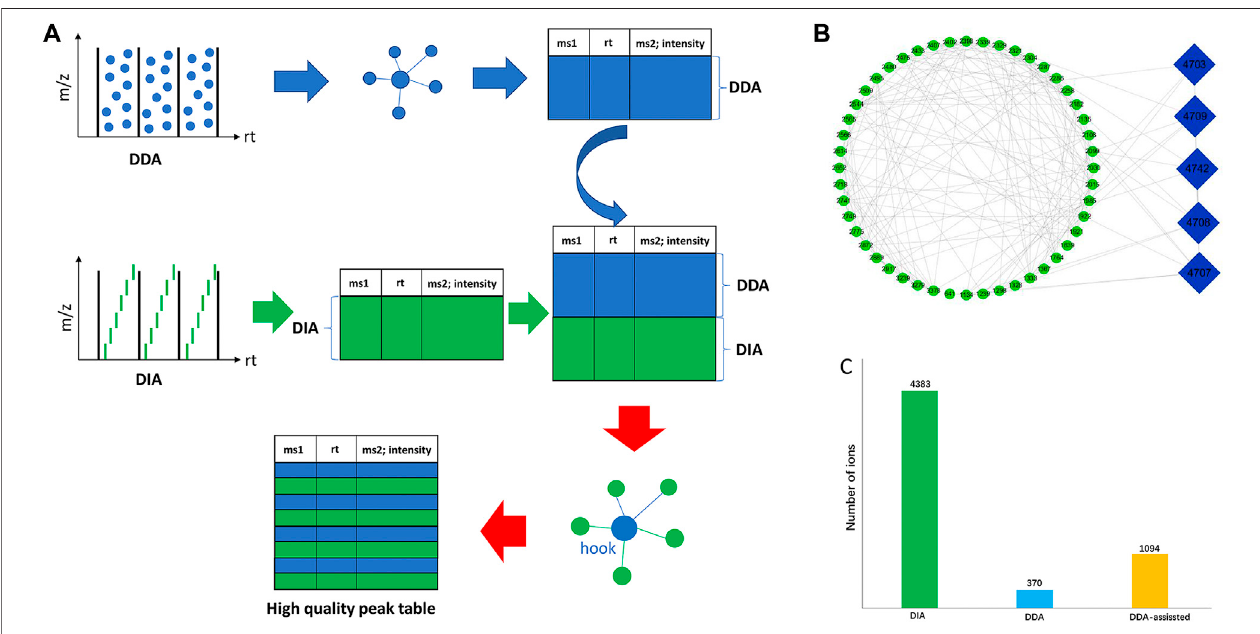
FIGURE2 |(A) Overall work fl ow of DDA-assisted DIA analysis. (B) Speci fi cillustration of DDA-assisted DIA. The green ellipse representsthe DIA MS features, and the blue diamond represents the DDA MS features. The edges were produced by the combination of similar MS 2 features of DDA and DIA through GNPS analysis. (C) Summary of MS features through DIA, DDA, and DDA-assisted